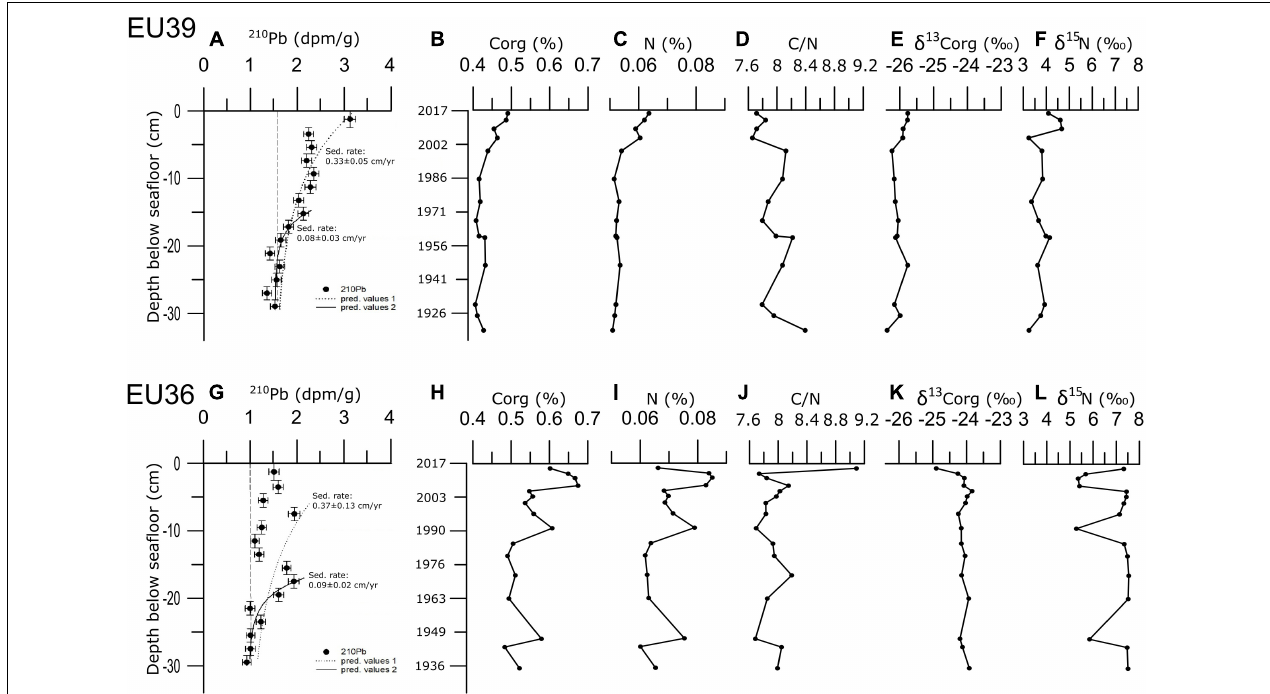
FIGURE 10 | Geochemical variables and sedimentation rates for EU39 (A–F) and EU36 (G–L) cores, plotted against depth below seafloor (cm) and AD years from 210Pb dating. (A,G) 210 Pb activity and sediment rates (two models). Vertical segmented lines are showing the supported activity (background). Error bars are indicated (2 σ ). (B,H) Total organic carbon content. (C,I) Total nitrogen. (D,J) C/N molar. (E,K) δ 13 Corg stable isotope. (F,L) δ 15 N stable